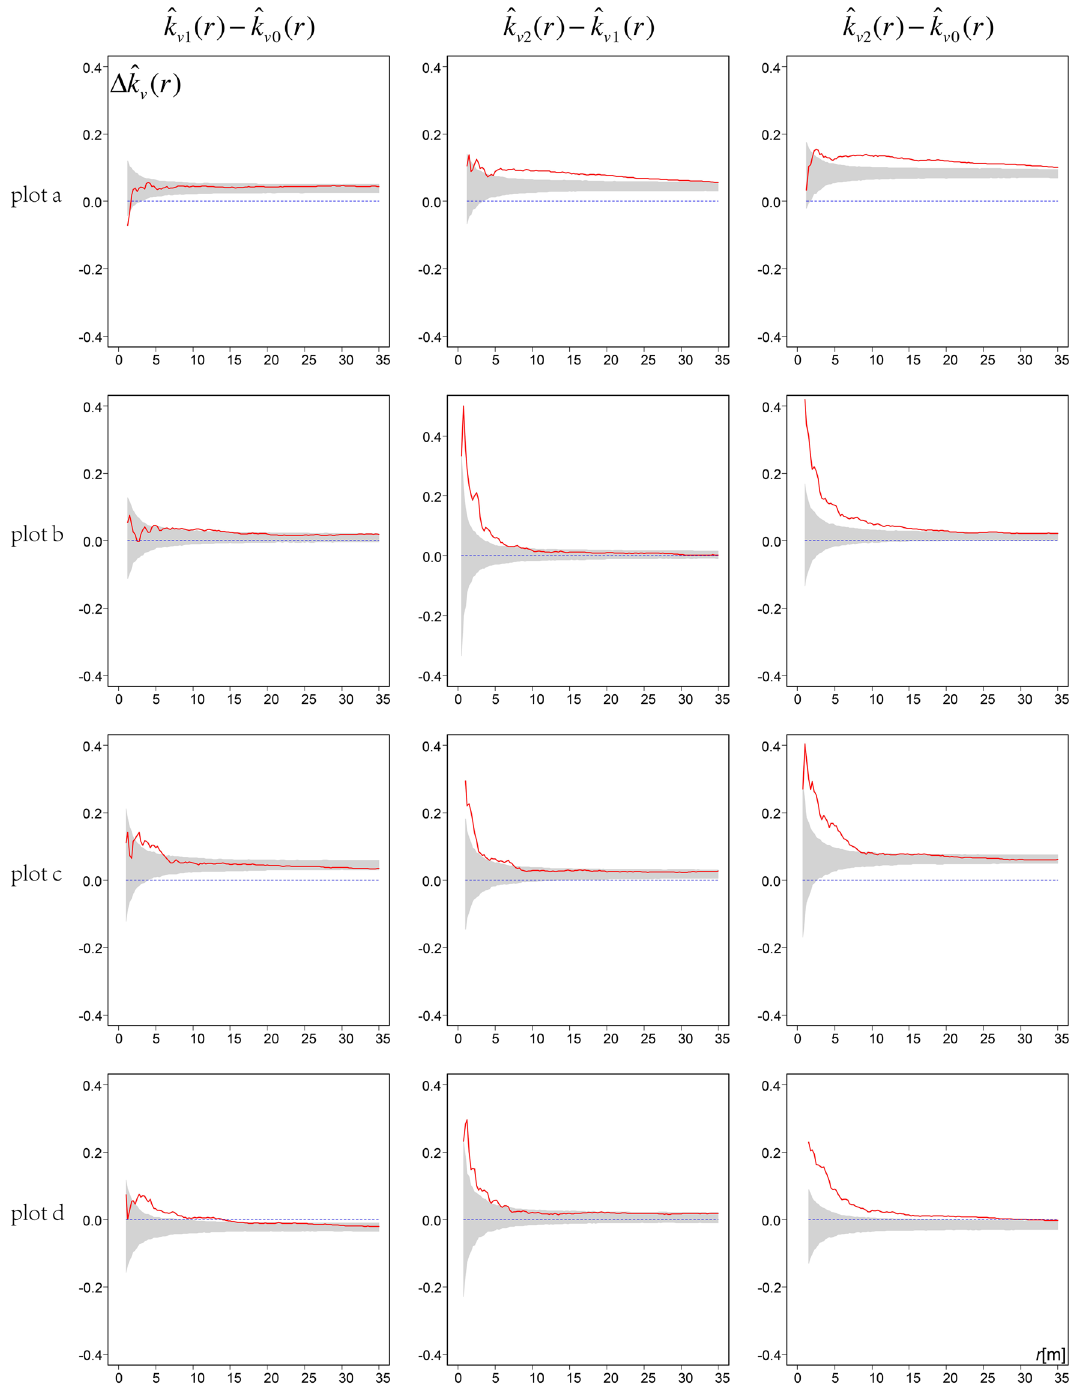
∆ ˆ ) among small, medium and large trees in each Figure 5. Differences in neighborhood species mingling ( k r ( ) v plot. Solid curves: observed ˆ ∆ k r ( ) ; envelopes (grey areas) were constructed from the 2.5% and 97.5% quantiles v of 1000 Monte Carlo simulations. Heading subscripts 0, 1, and 2 denote three dbh size classes (small, medium, and large, respectively). Note: Larger trees exhibit higher neighbourhood mingling than do smaller trees if the curves lie above the simulation envelopes. Curves that lie within the simulation envelopes indicate no differences in neighbourhood mingling between larger and smaller